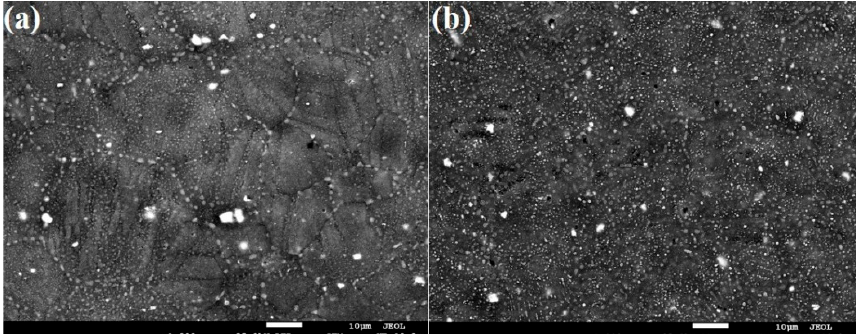
Figure 4. SEM images of the rolled AZ80 alloys pre-aged for ( a ) 75 and ( b ) 240 min.